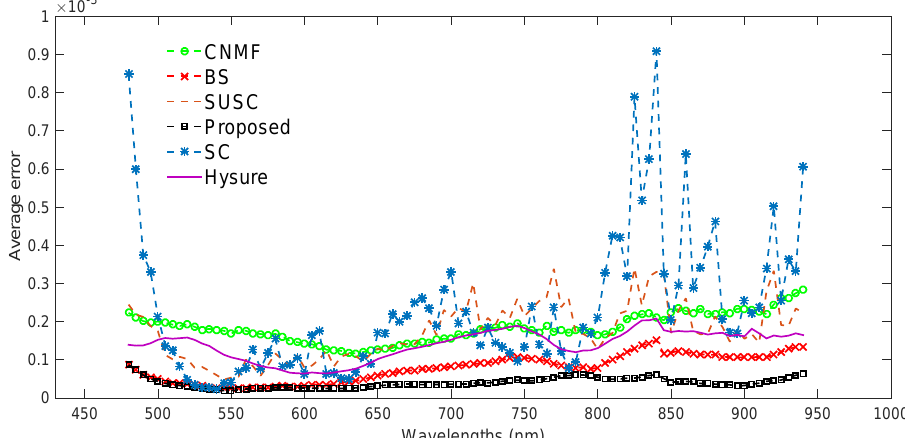
Figure 6. Average squared error between obtained and ground truth spectra of 1031 randomly sampled pixels of the Pavia image for the different methods.